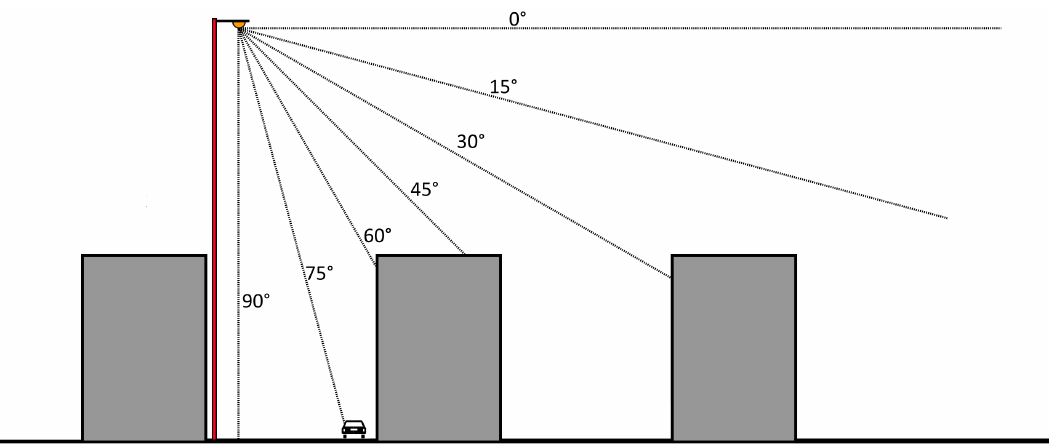
Figure 2. Variable path geometry inherent with wide field-of-view near-ground sensor visualized over an idealized two-dimensional urban